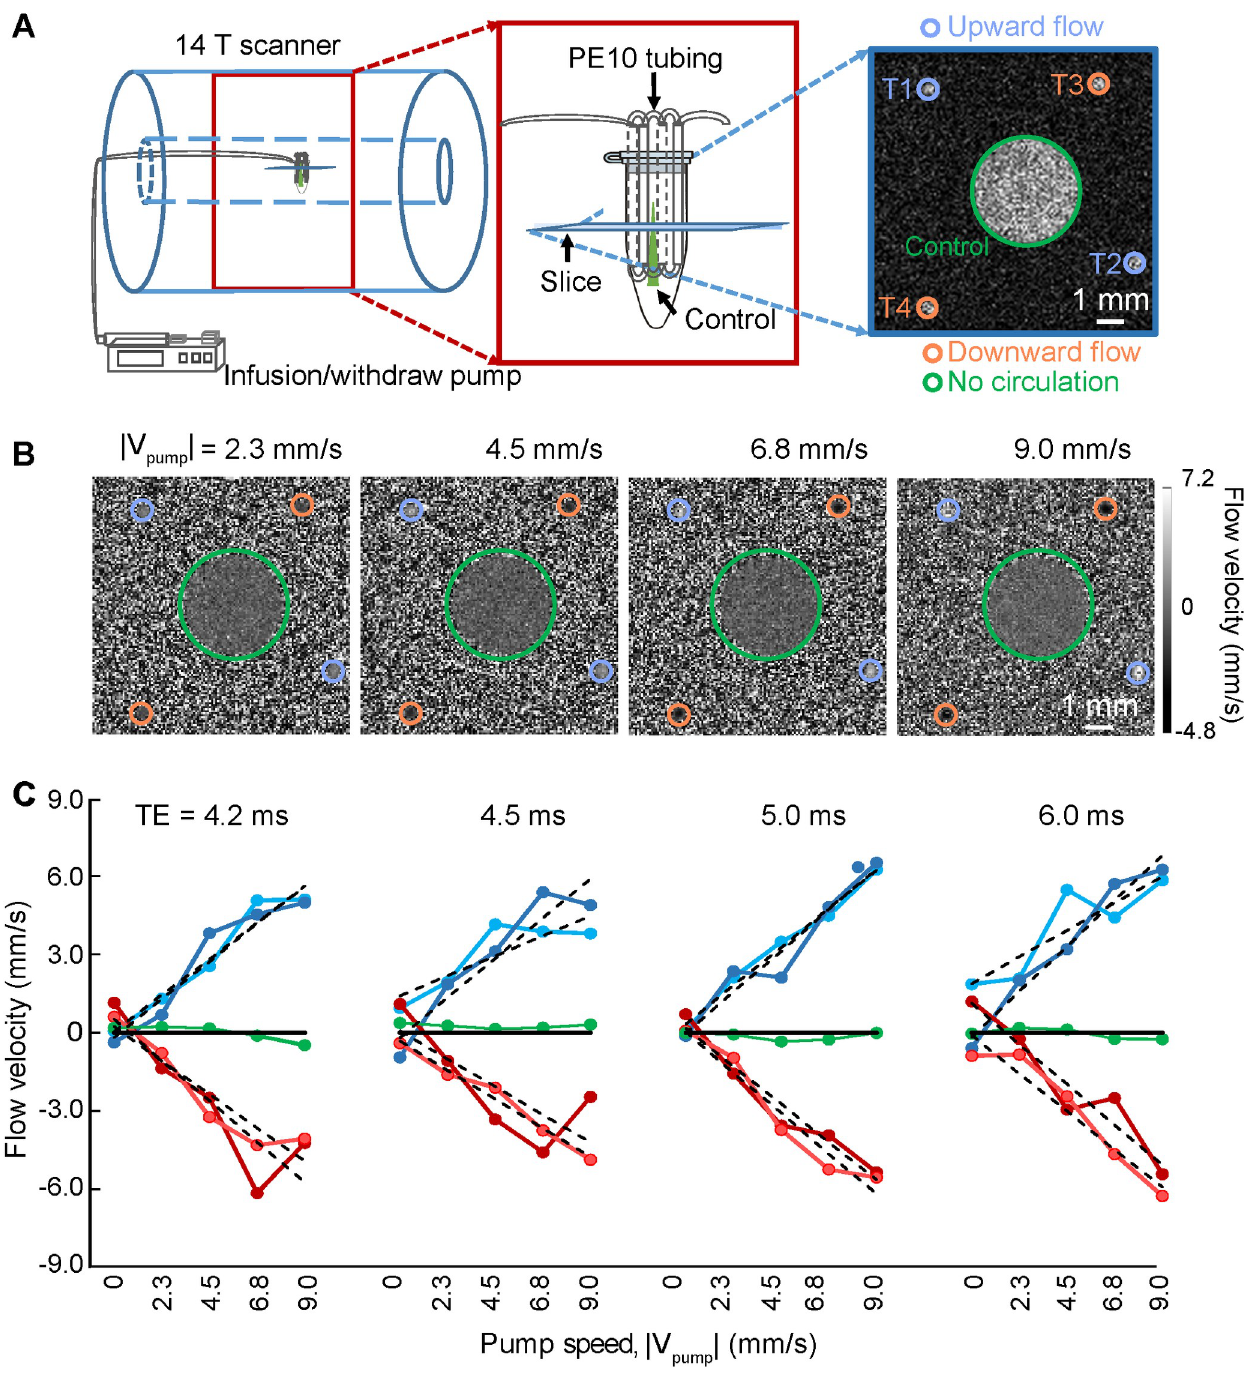
Fig 1. In vitro flow velocity measurements with PC-MRI. (A) Schematic drawing of the phantom experimental flow chamber in the 14.1 T scanner. An expanded image (red box) shows the circulatory system constructed of capillary tubes. A representative FLASH MRI image (blue box), 500 μ m in thickness, shows the capillary positions. ROIs T1 and T2, contoured in purple, indicate the upward flow. ROIs T3 and T4, in orange contour, indicate the downward flow. The green contour indicates the stagnant fluid. (B) Representative images with different flow velocity in the capillaries T1 to T4 in panel A. TE = 5.0 ms for all panels. (C) The plot of flow velocity estimates from the 5 ROIs with different TEs, as marked, and different pump rates, as indicated and marked in panel B. The dotted lines correspond to a linear fitting for velocity measurements of different ROIs. The data underlying this figure can be found in S1 Data. F AU : AbbreviationlistshavebeencompiledforthoseusedthroughoutFigs 1 (cid:0) 3 : Pleaseverifythatallentriesarecorrect : LASH, fast low angle shot; PC, phase contrast; ROI, region of interest; TE, echo time.